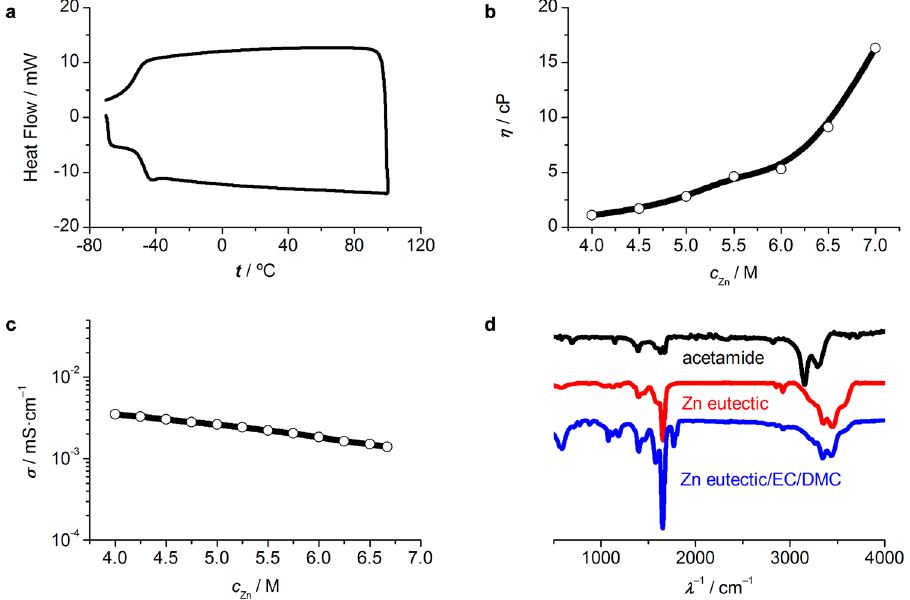
Figure 2. Characterization of Zn eutectic solvent. ( a ) Power-compensated DSC heating and cooling hysteresis profile of the as-prepared Zn eutectic solvent in a temperature range from − 80 to 100 °C; ( b ) room-temperature viscosity and ( c ) ionic conductivity of Zn eutectic solvent; ( d ) FTIR spectra of acetamide, Zn eutectic solvent and Zn eutectic mixture. The equivalent concentration of ZnCl 2 in the Zn eutectic mixture is 5